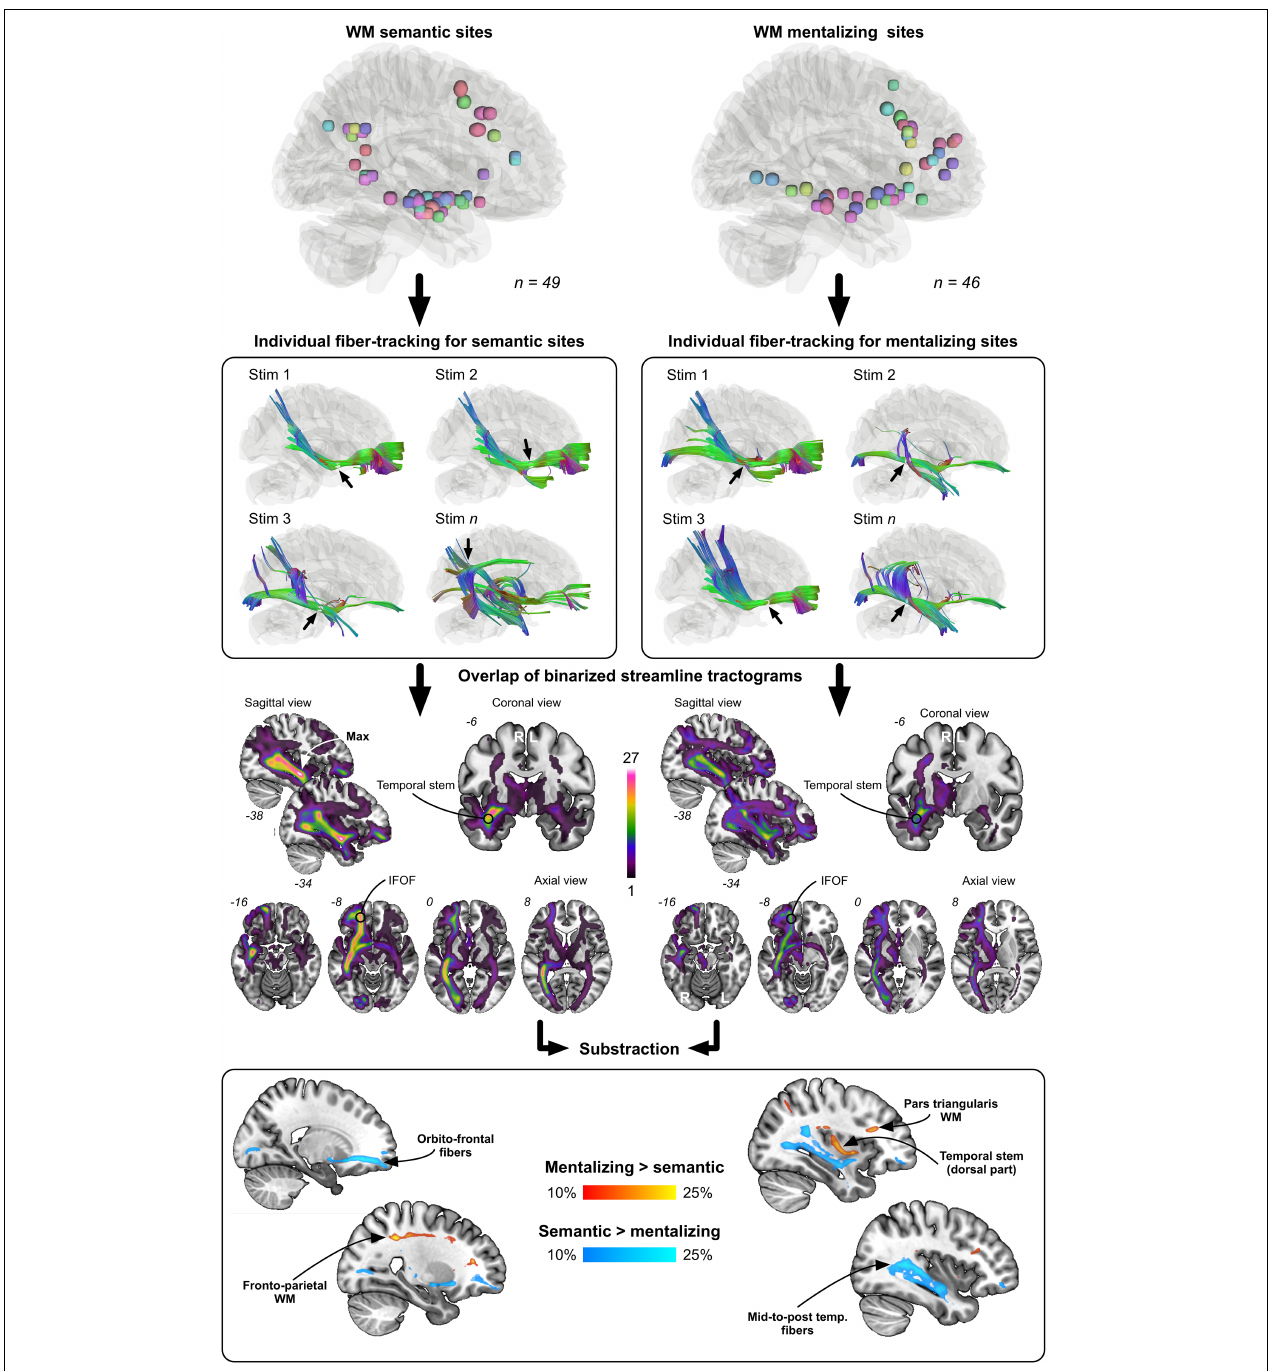
FIGURE 5 | Results from the disconnection analysis. Each WM site was used to generate individual streamline tractograms. These tractograms were next binarized and overlapped according to each function (semantics vs. mentalizing). Last, the overlap maps were contrasted to visualize the fiber pathways the most frequently and specifically tracked from mentalizing sites (red to yellow color) and semantic sites (dark blue to light blue color).